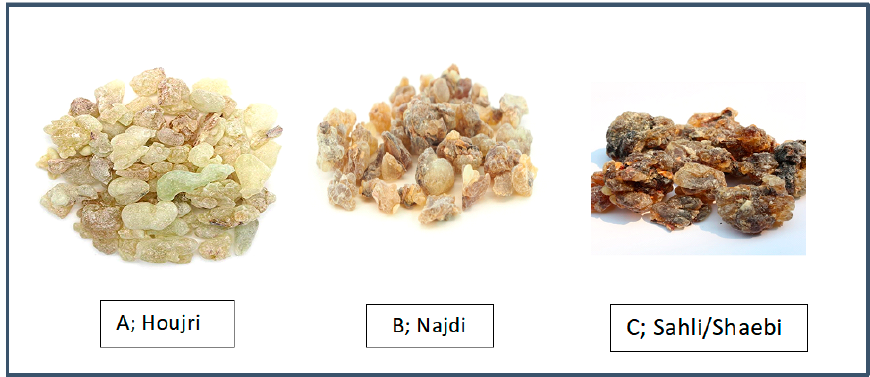
Figure 1. Omani commercially available B. sacra resin samples: A Houjri, B Najdi, and C